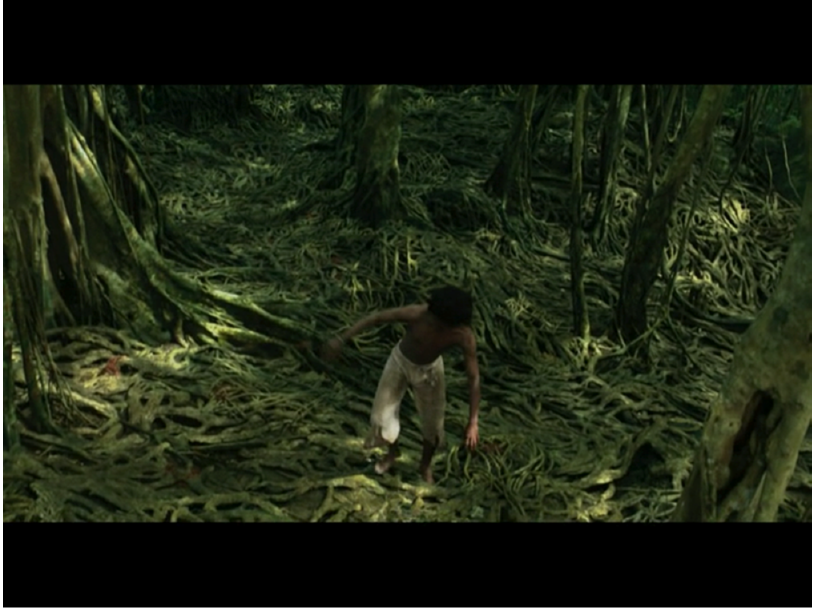
Figure 8. The carnivorous island is modeled on the interconnected roots of the banyan tree.